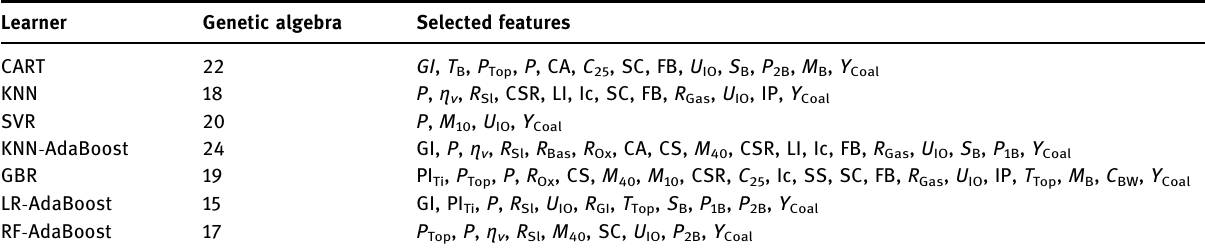
Table 2: Genetic algebra and the optimal feature sets in GA - learners Learner Genetic algebra Selected